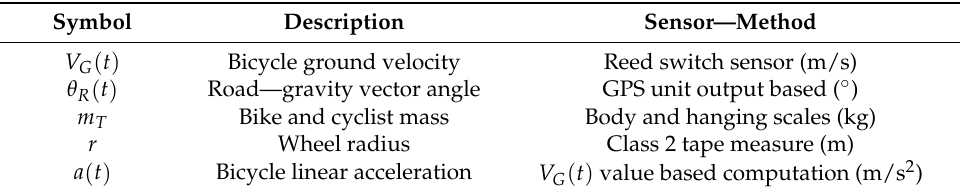
Table 3. Time-variable parameters.